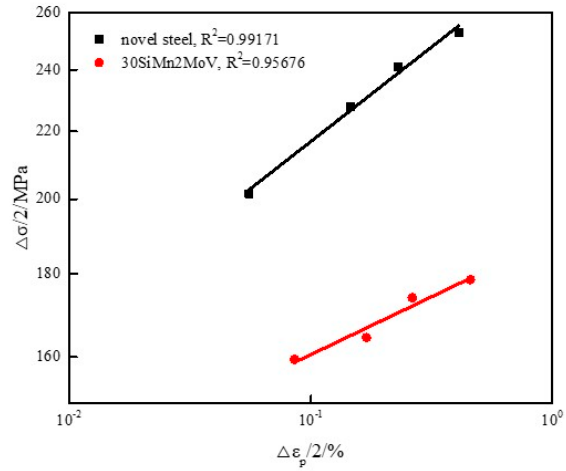
Table 3. The cyclic stress–strain parameters of the novel steel and 30SiMn2MoV steel.